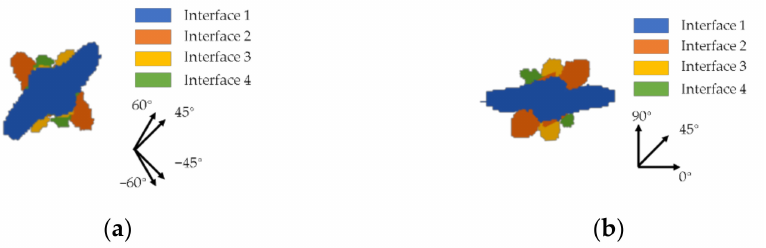
Figure 14. The delamination occurred in the front layers of the GFRP laminates with layout ( a ) test 3 and ( b ) test 7 at 0.05 ms.